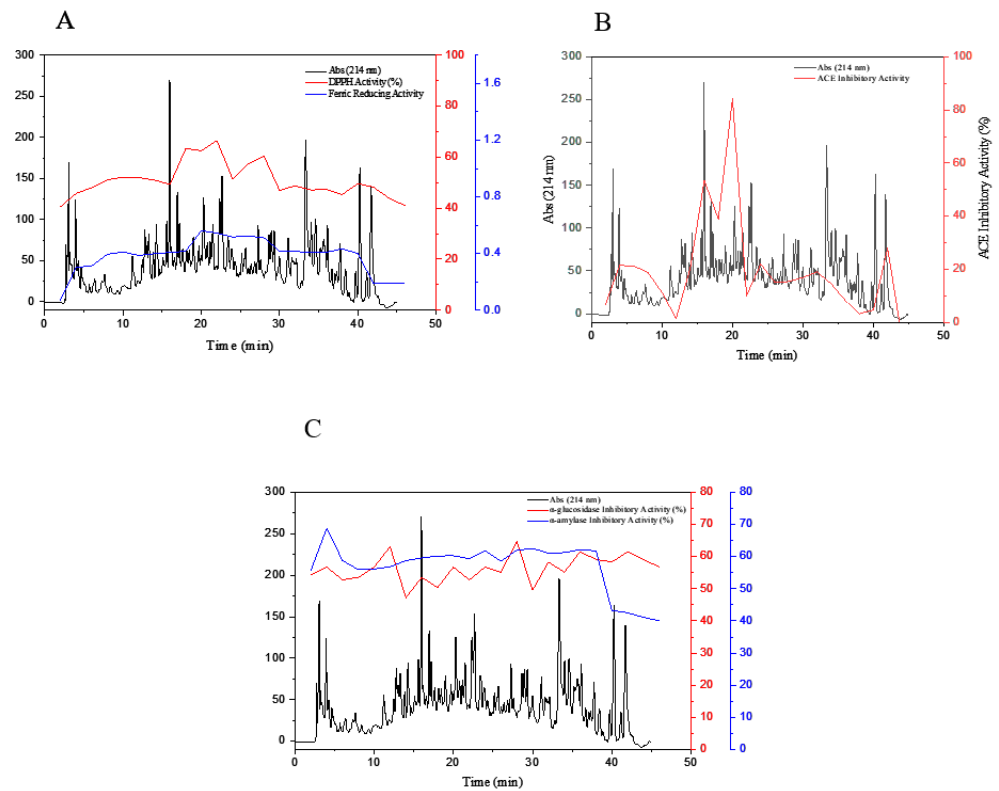
Figure 6. Reversed-phase high-performance liquid chromatography (RP-HPLC) separation of Fractions (40–44) and (45–49) obtained from SEC. The fractions were automatically collected and assayed for their DPPH scavenging activity and ferric-reducing power ( A ), ACE-inhibitory activity ( B ), and α -amylase-inhibitory activity, and α -glucosidase-inhibitory activity ( C ). Fractions 19 to 20, obtained from RP-HPLC, were selected for further sequencing and identification.